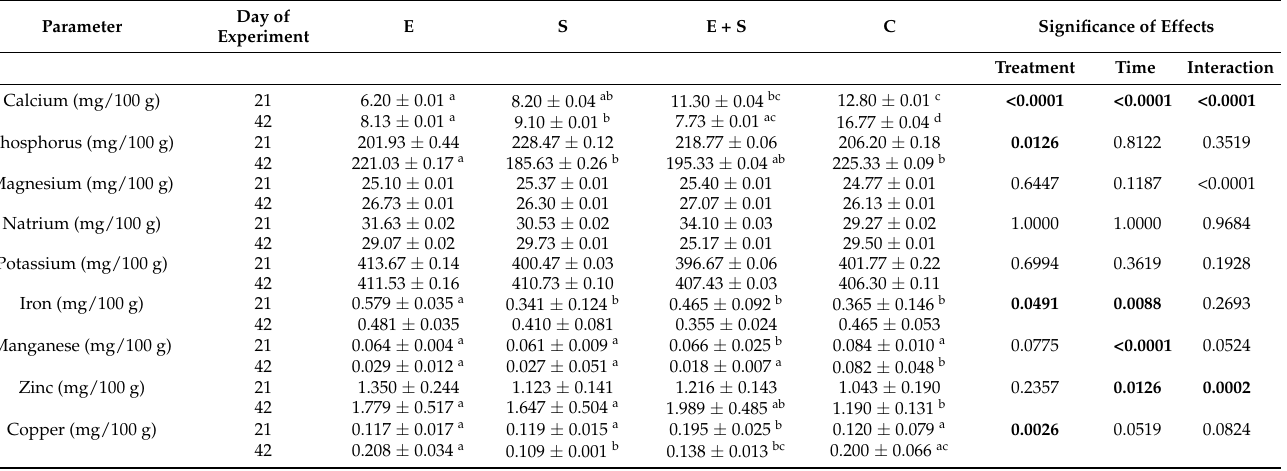
Table 3. The effect of Ent 7420 (E), sage extract (S) and their combinative (E + S) application on the meat mineral content of rabbits Longissimus thoracis and lumborum ( LTL ; mean ±